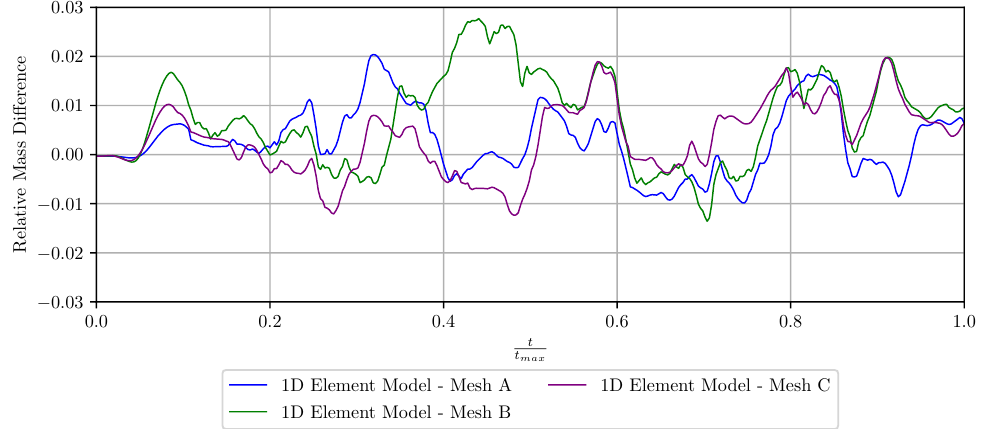
Figure 19. Relative mass difference in left-hand side of the tank of one-dimensional orifice element model simulation to full-resolution simulation of the violent slosh test case.